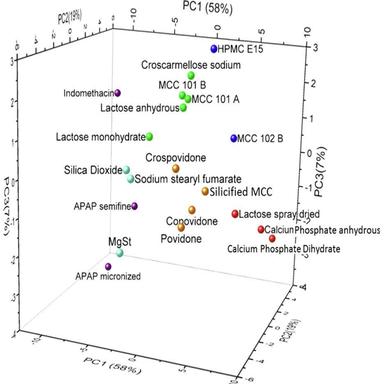
A cubic score plot based on principal component analysis that shows distribution of different materials in the projected space. Material is color coded based on a subsequent clustering analysis.